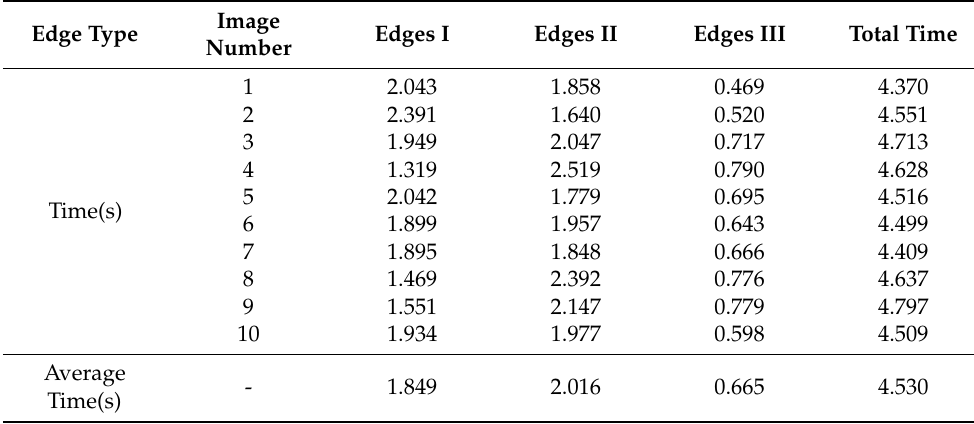
Table 5. The computational time of each type edge. Edge Type